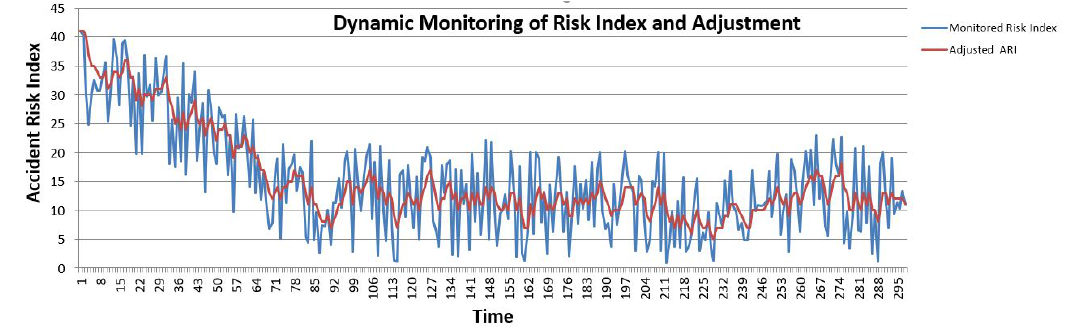
Figure 12. Effect of State of Charge (SoC) over